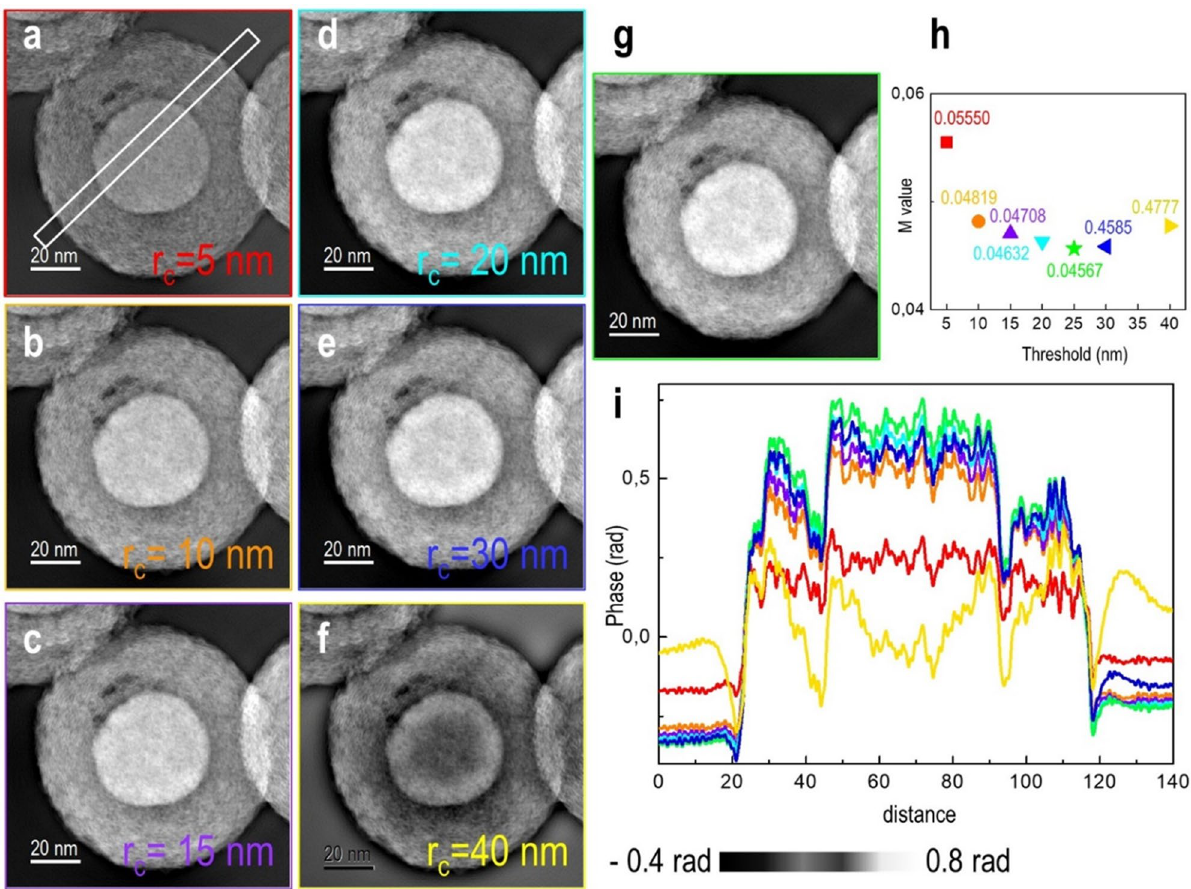
Figure 2. Phase images of Fe-filled C nanospheres reconstructed using ( a ) 5, ( b ) 10, ( c ) 15, ( d ) 20, ( e ) 30, ( f ) 40, and ( g ) 25 nm threshold values. ( h ) Threshold vs. M value (mismatch between simulated and experimental images). ( i ) Line profiles of ( a –( g ) from the region marked in ( a